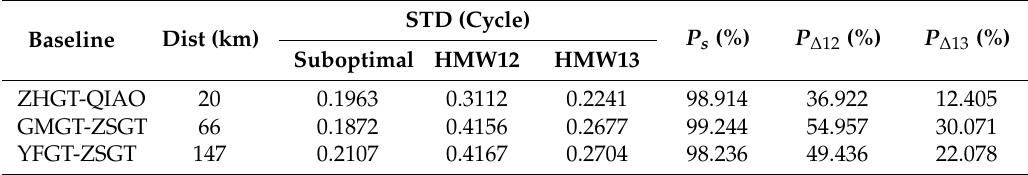
Table 6. Performance comparison for all IGSO and MEO satellites among the suboptimal , the HMW 12, and the HMW 13